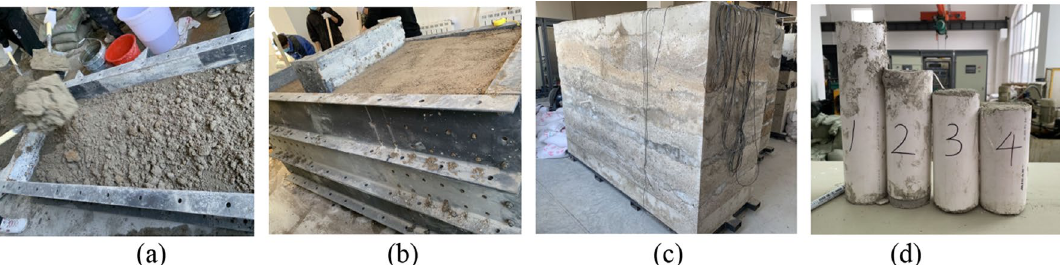
Figure 11. Rock wall construction and specimens: ( a ) filling; ( b ) compacting; ( c ) rock wall model; ( d ) specimens.